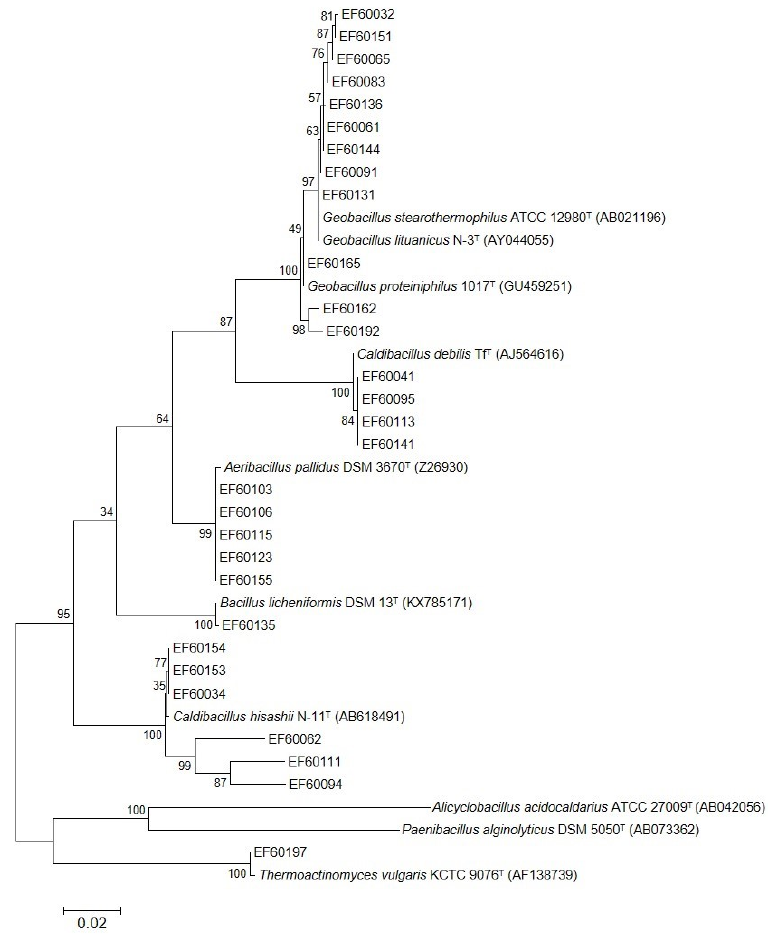
Figure 2. Phylogenetic analysis of 29 isolates and their closely related type strains. The phylogenetic tree was constructed based on 16S rRNA gene sequence alignments using the Maximum Likelihood method in MEGA 6.0. Bootstrap values are indicated at the branch points. The scale bar indicates a branch length equivalent to 0.02 changes per nucleotide. Alicyclobacillus acidocaldarius ATCC 27009 T and Paenibacillus alginolyticus DSM 5050 T served as outgroup.